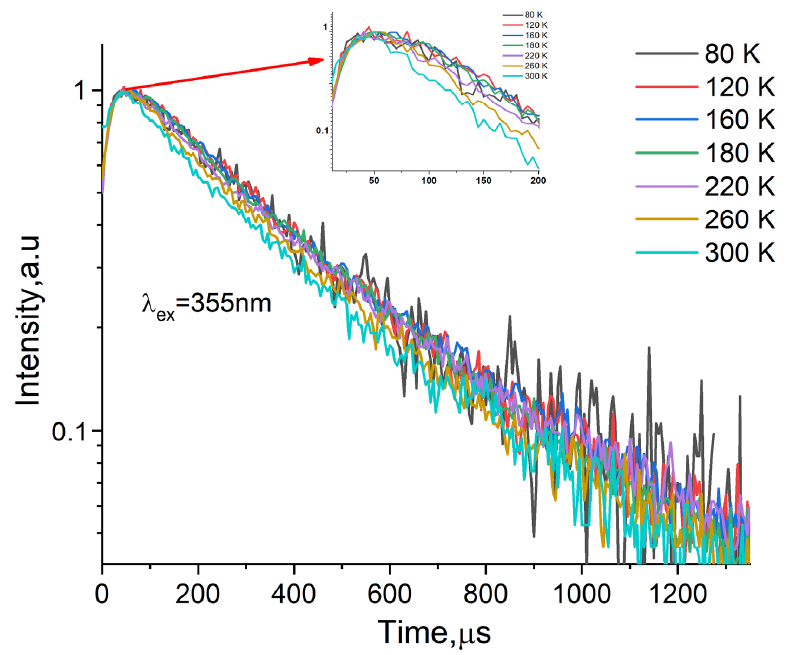
Figure 9. Lifetime curves of Nd 3+ (0.3%), Yb 3+ (2.0%):LiYF 4 sample under 355 nm excitation in the 80–320 K range.